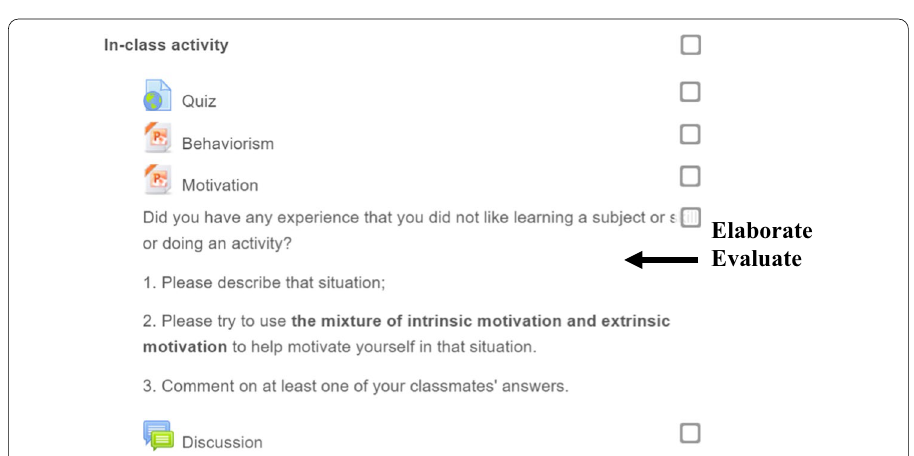
Fig. 6 Example of an in-class activity in Course